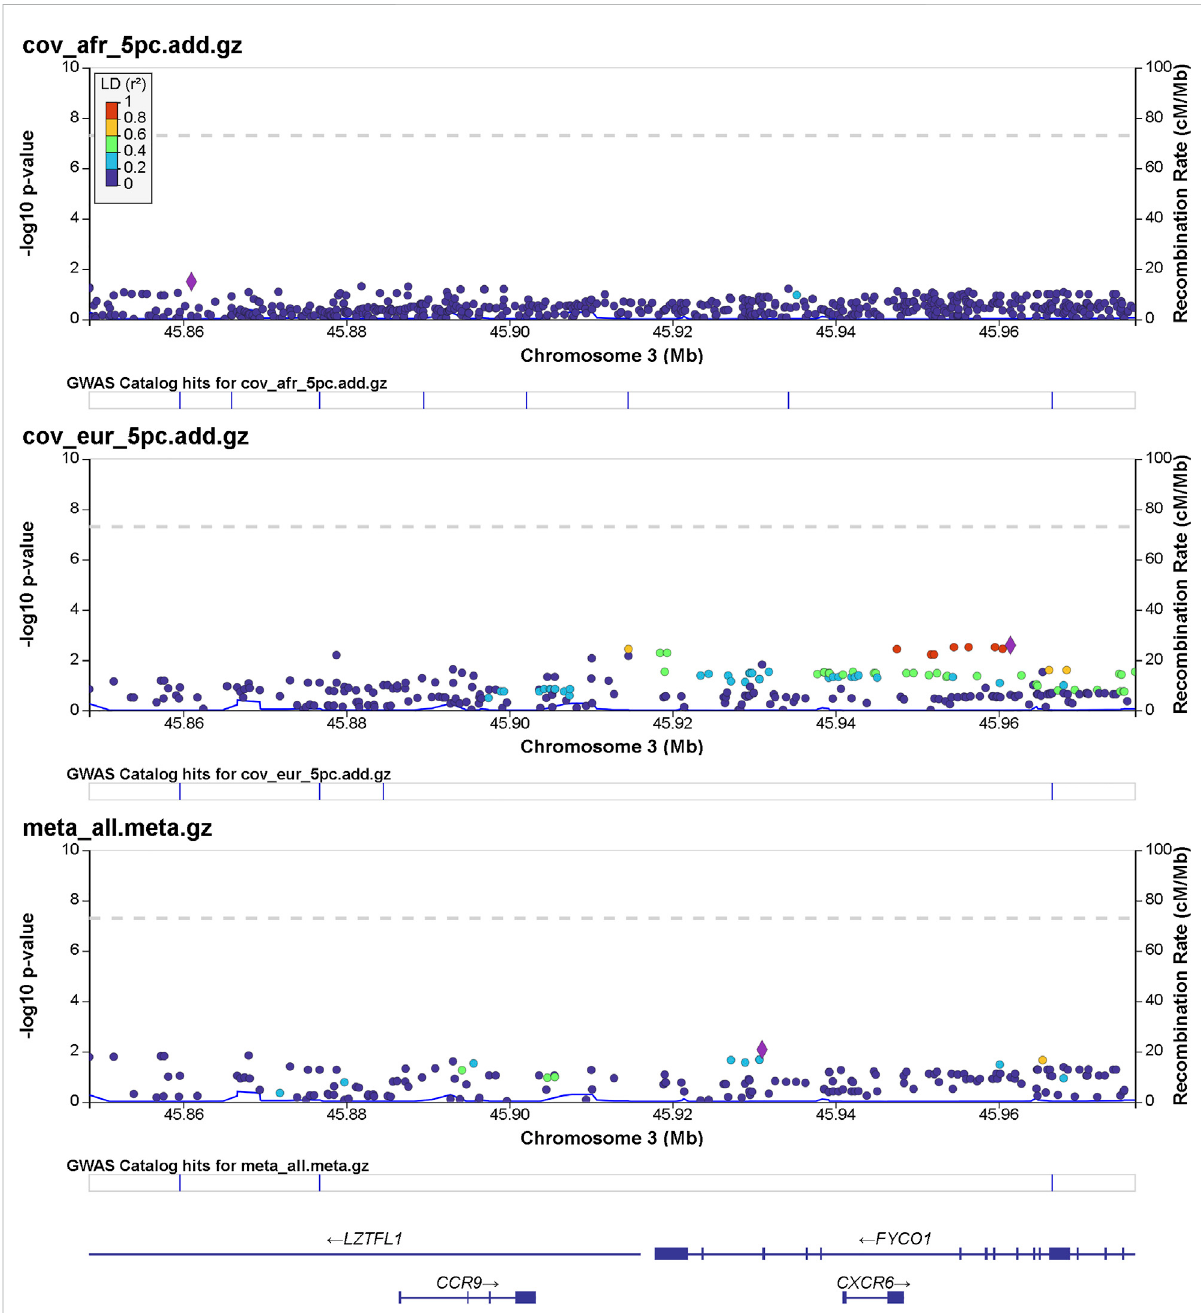
FIGURE 1 Regionalsigni fi canceplotofthe3p21.31regionbyLocusZoom(Pruimetal.,2010).Thegenes CCR9 , CXCR6 , FYCO1 ,and LZTFL1 areincludedin this region. The peak of signi fi cance is from the SNP 3:45961470:T:C (rs1601867) at the intronic region of FYCO1